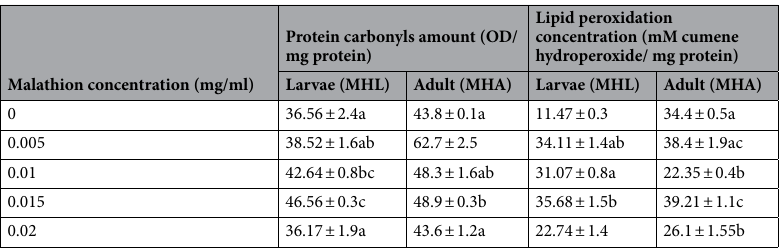
Table 1. The macromolecules oxidative damage in form of amount of protein carbonyls (OD/ mg protein), and concentration of lipid peroxides (mM cumene hydroperoxide/ mg protein). The protein carbonyls and lipid peroxides concentrations were obtained from gut homogenates of 5th instar larvae and males of Hermetia illucens , which their food containers were exposure to different concentration of malathion (0, 0.005, 0.01, 0.015, 0.02 mg/ml). The data were expressed as mean ± SE. Mean values marked with the different lowercase letters were significantly different among malathion concentration assessment (ANOVA test Tukey’s-b , Post Hoc test, p <